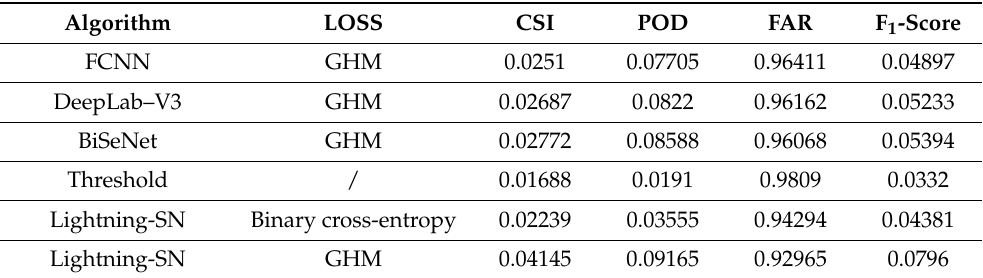
Table 4. Performance comparison between different